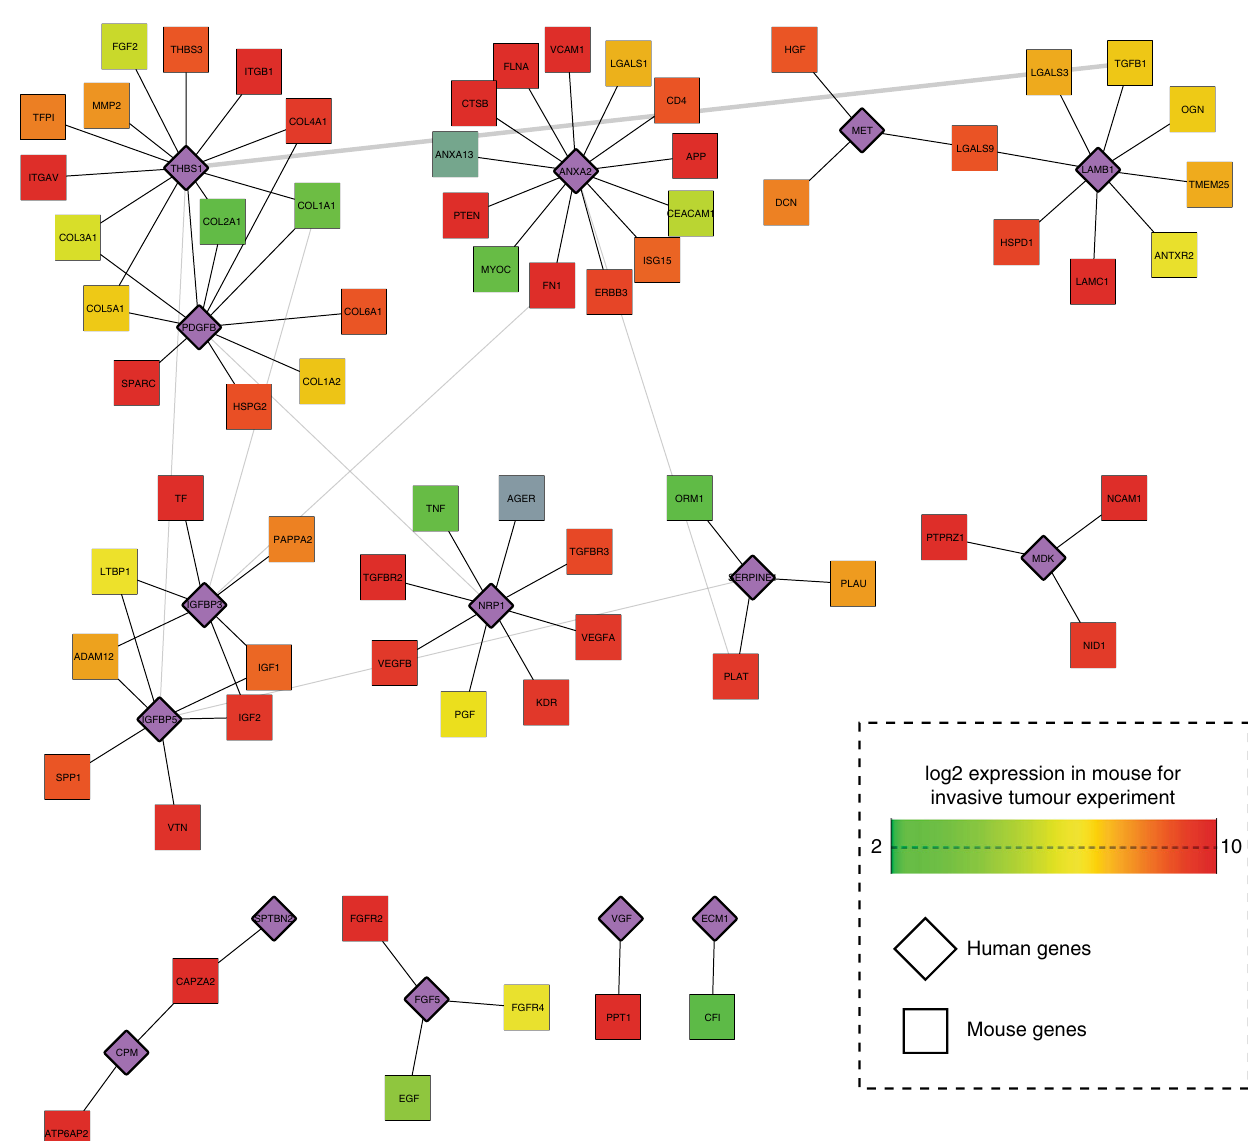
Fig. 7 Transcriptional analysis highlights THBS1 as central regulator of GBM invasion. A network of proteins encoded by genes that are overexpressed in the invasive area of P3 tumours when compared to the core area, or are expressed by the host. Relationships in the network represent known protein – protein interactions. Human genes are represented in purple and mouse genes are colour coded according to their expression (green (2) – red (10); normalised counts in log2